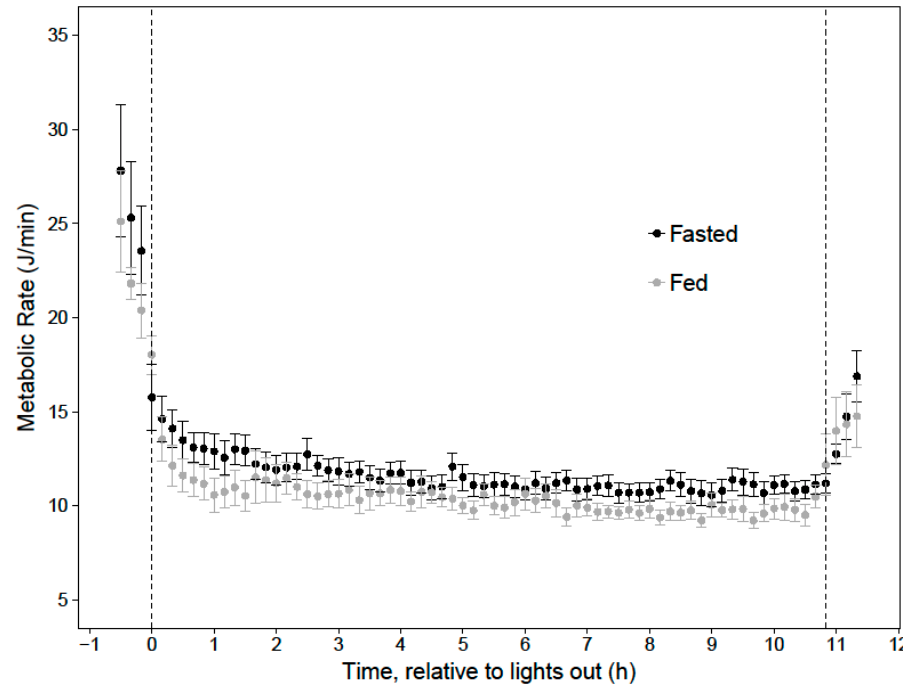
Figure 1. Overnight metabolic rates (J/min) exhibited by ruby-throated hummingbirds in fed and fasted trials, relative to the time of lights-out (time = 0). Vertical dashed lines indicate time of lights off and on. Data are presented as mean ± SEM of 10-min bins averaged across the individual birds (n = 6).